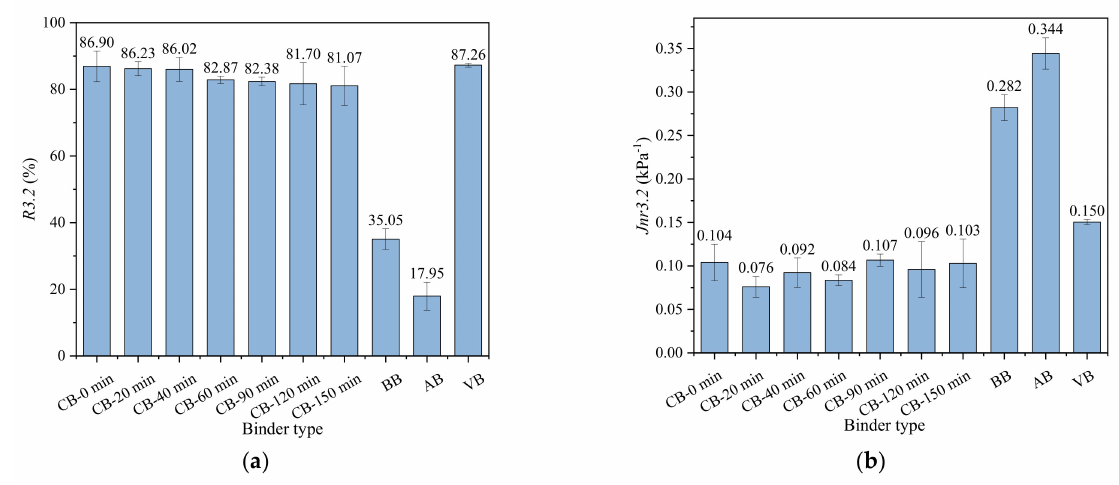
Figure 10. Results from MSCR tests for various binders. ( a ) R3.2 ; ( b ) Jnr3.2